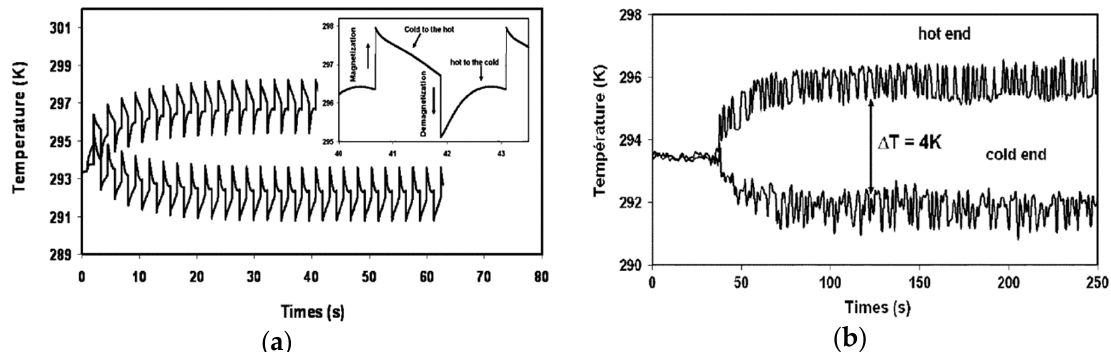
Figure 13. Evolution of the temperature versus the time for the cold and hot ends of the regenerator obtained by the: ( a ) numerical model and ( b ) experimental measurements [53].